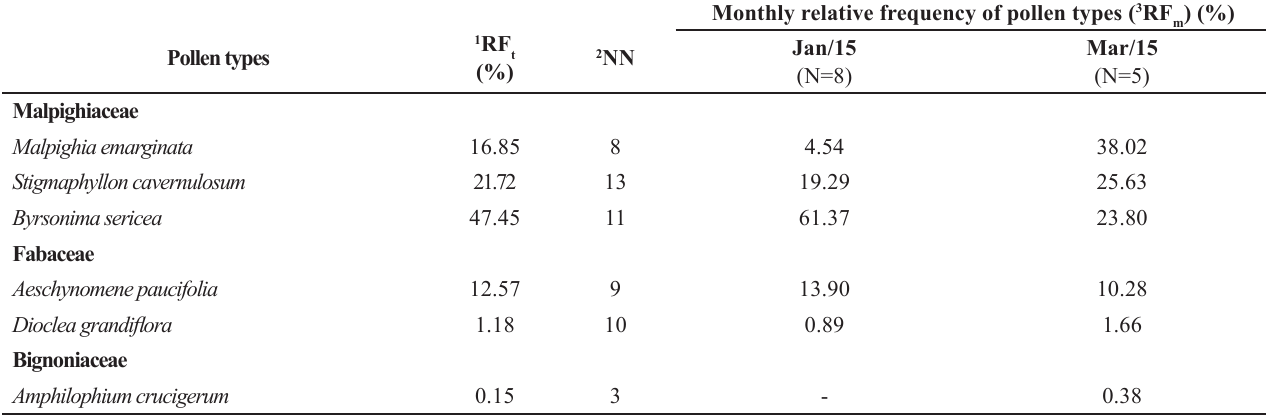
Table 4 . Relative frequencies of pollen types in larval food from 13 nests of Centris terminata Smith, 1874 collected from Parque Zoobotânico Getúlio (PZBGV) in urban fragment of Atlantic Forest in Salvador, Bahia,